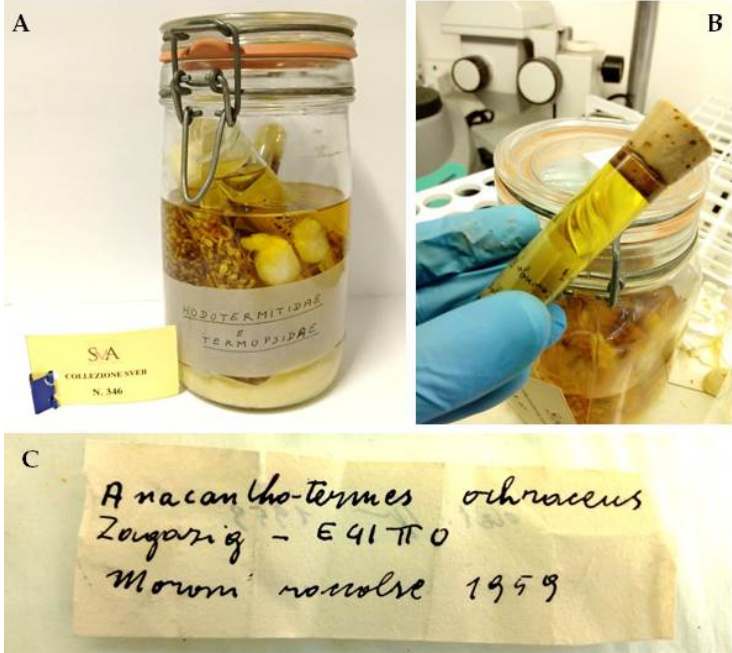
Figure 1. Springhetti Collection. ( A ) Example of a Korken glass jar (jar 18) containing the termite specimens, with its original label and the assigned SMA cataloguing number. ( B ) Example of a test tube with specimens preserved in alcohol. ( C ) Example of an original label with general information about the specimens.